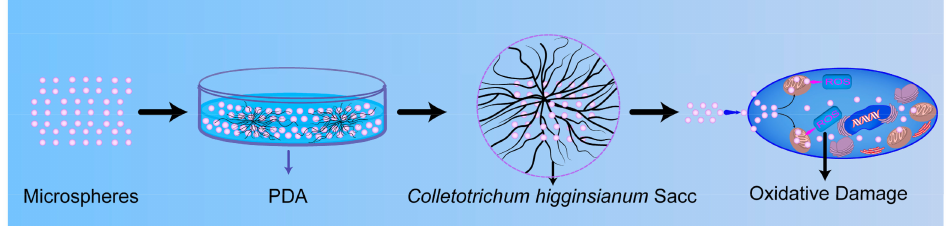
Figure 16. Antifungal schematic illustration of the azoxystrobin microspheres against Colletotrichum higginsianum